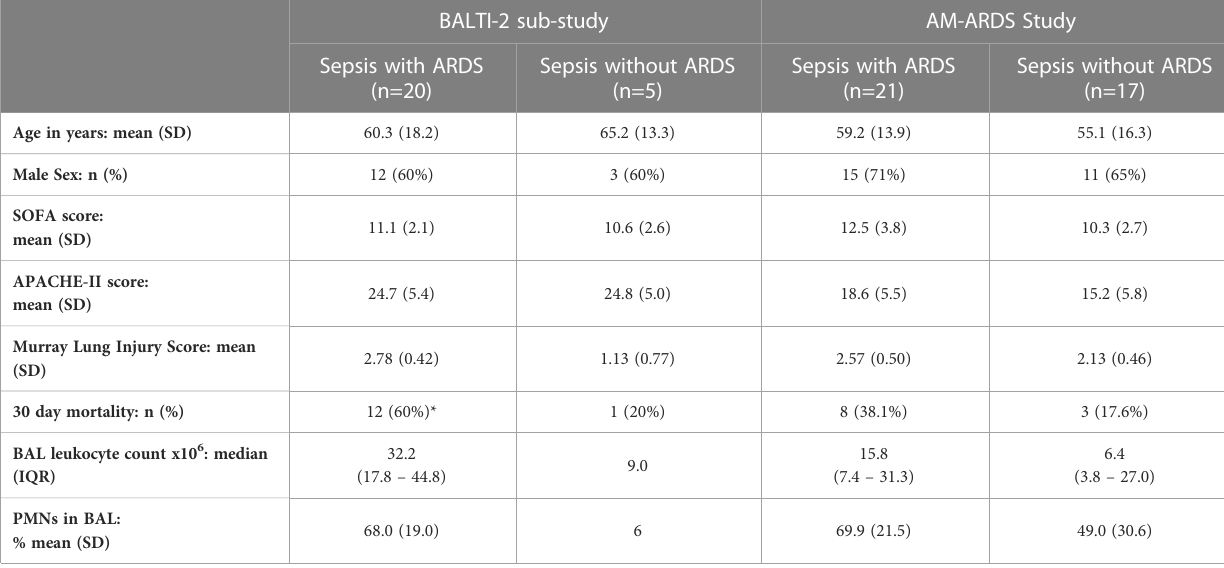
TABLE 1 ICU Patient Demographics and Physiological